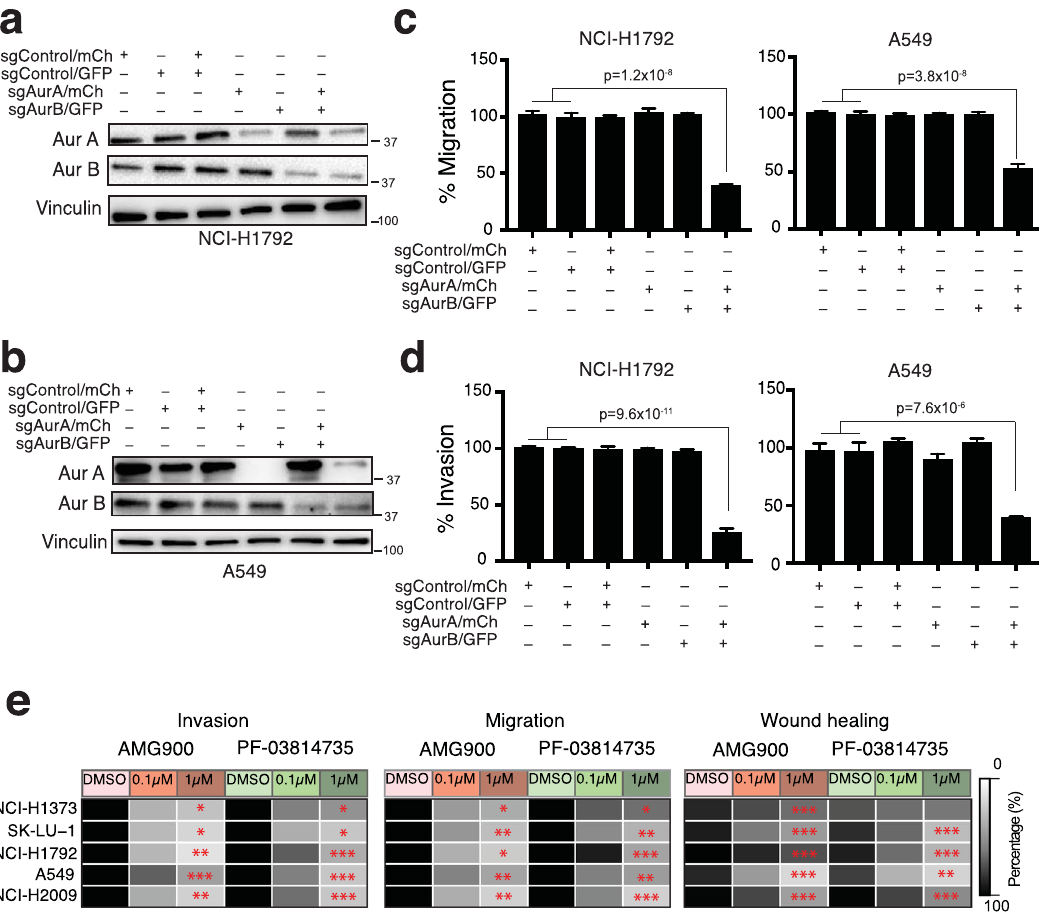
using a generalized linear model (Methods). All statistical test results are listed in Supplementary Table 7. Source data are provided in Source Data fi